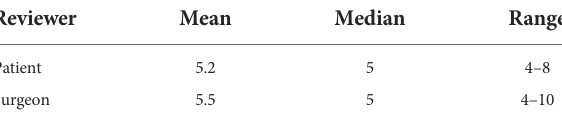
TABLE 2 Patients